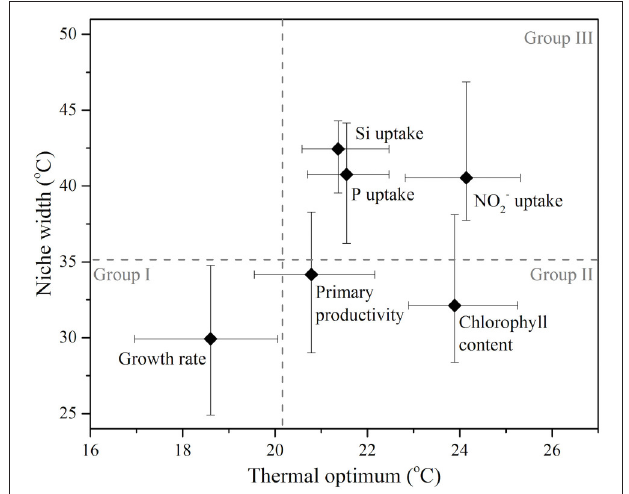
FIGURE 8 | Thermal performance curves of fitness ( gray band ) and other functional traits including primary productivity ( green band ), cell volume ( blue band ), and frustule silicification ( red band ) in the marine diatom Thalassiosira pseudonana (CCMP 1335) originally isolated from the North Atlantic Ocean. Each confidence band represents the maximum likelihood estimate with 95% confidence intervals, both estimated by parametric bootstrapping for each functional trait. Solid vertical lines correspond to the thermal window currently experienced in the North Atlantic Ocean ranging from the minimum boreal winter temperature ( 10 ◦ C) and ∼ maximum boreal summer temperature ( 25 ◦ C), both estimated from monthly ∼ sea surface temperatures for December 2014 and July 2015 obtained from NOAA. Broken line depicts predicted estimates of future sea surface temperature warming of the North Atlantic Ocean ( Boyd et al.,